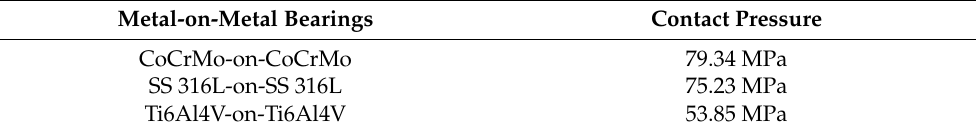
Figure 5. Maximum contact pressure for three types of metal-on-metal bearings. Table 1. Maximum contact pressure for different metal-on-metal bearing materials at peak loading.